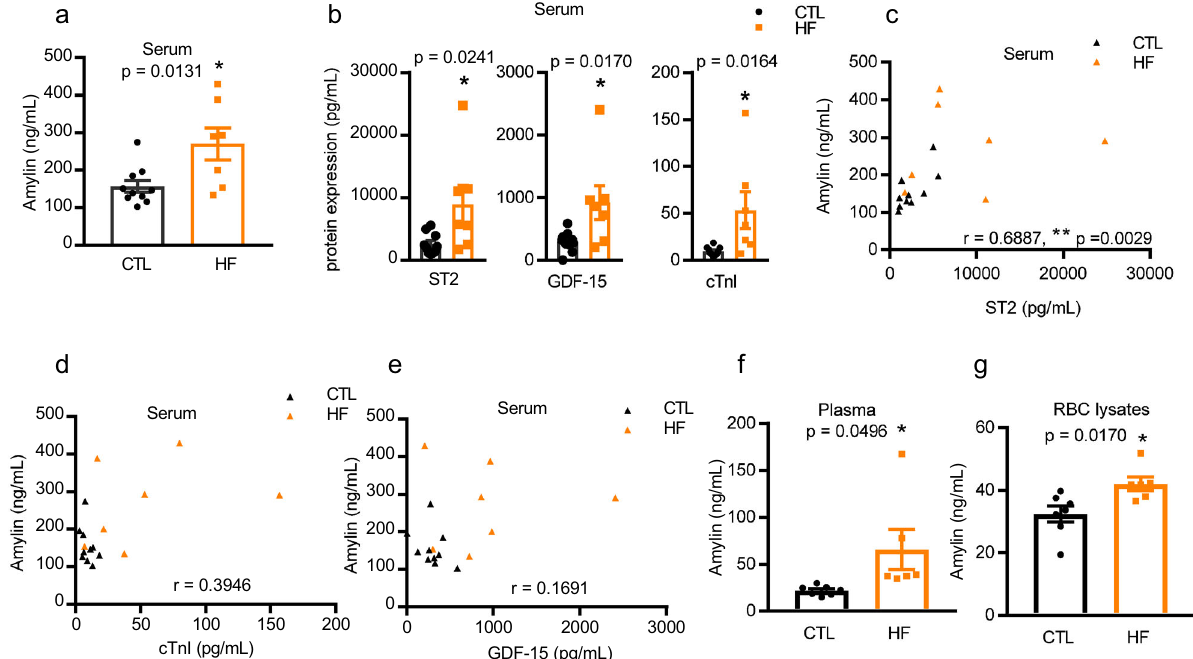
Fig. 3 Circulating amylin and HF markers levels in NHPs. a Amylin concentration in serum from a parallel set of NHPs (CTL, n = 10; HF, n = 7). b Protein levels of ST2, GDF-15, and cTnI in serum as in panel ( a ). c – e The correlations between serum amylin level and ST2 ( c ), cTnI ( d ), and GDF-15 ( e ), respectively, in serum as in panel ( a ) and ( b ). Amylin levels in matched plasma ( f ) and RBC lysates ( g ) from the same animals whose hearts were used for histopathological evaluation in Fig. 1 and amylin assessment in Fig. 2 (CTL, n = 7; HF, n = 6). Data represent mean ± SEM. * P < 0.05; ** P < 0.01 by Student ’ s t test. The correlations between serum amylin level and ST2 ( c ), cTnI ( d ), and GDF-15 ( e ), respectively, were analyzed by Spearman nonparametric correlation analysis in GraphPad 7.04 (GraphPad Inc., San Diego, CA), and the values for the Spearman r were indicated on the